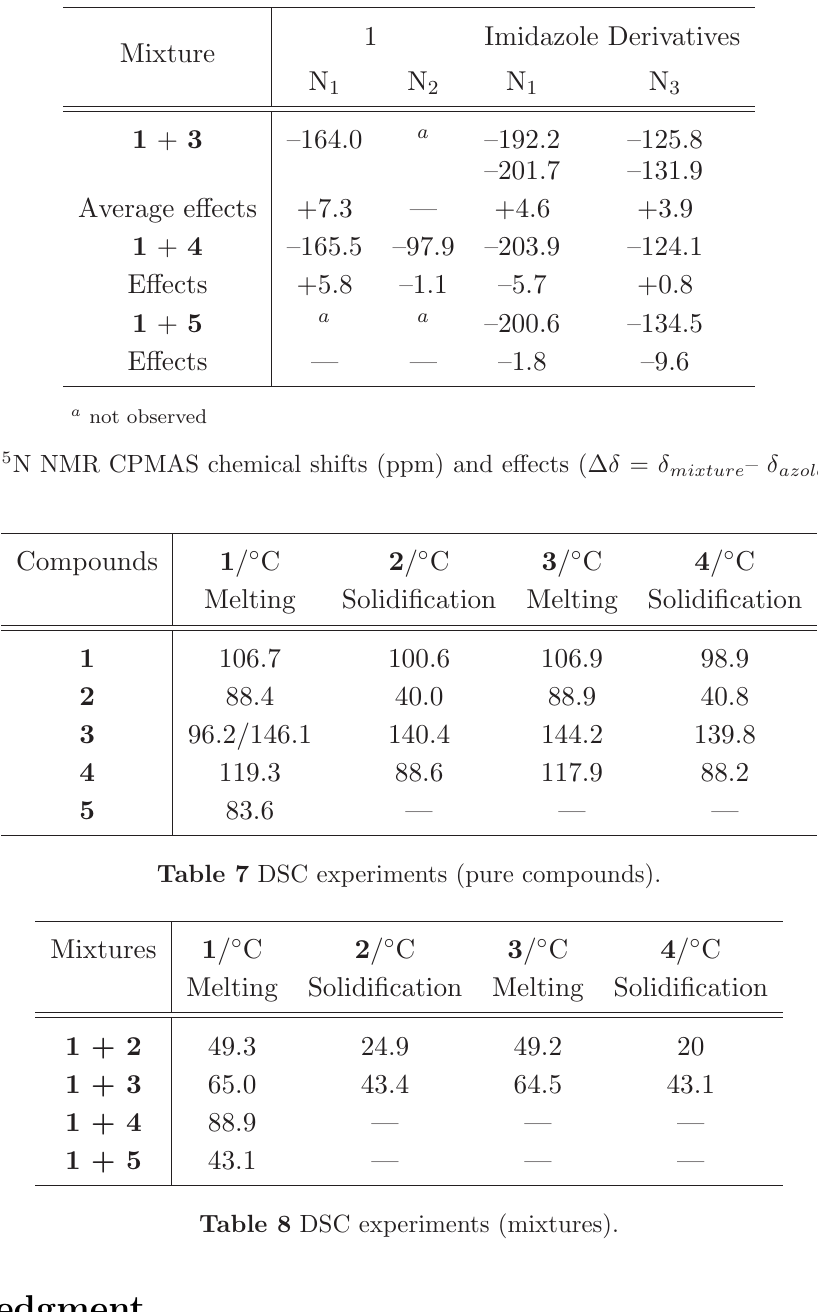
— — — Table 8 DSC experiments